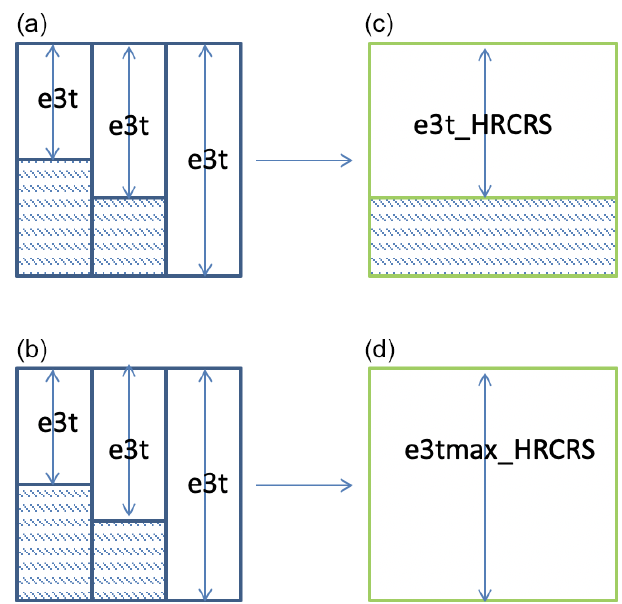
Figure 4. Schematic diagram illustrating the coarsening procedure for the vertical dimension (e3t) of grid cells from high-resolution ocean grid cells (blue lines, a , b ) to the corresponding coarsened biogeochemical grid cells (green lines, c , d